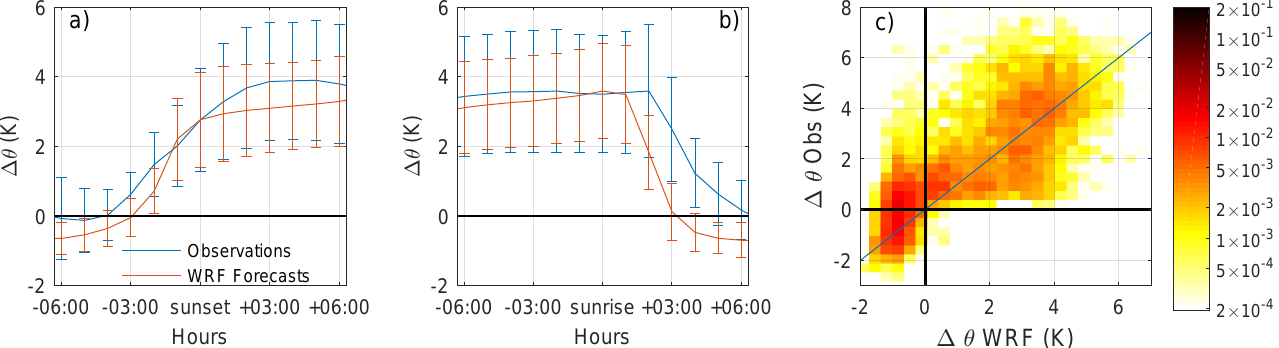
Figure 5. ( a ) Sunset-referenced mean diurnal cycle of potential temperature difference between 110m and 2m (1 year data). Blue color is for observations and red for simulations. Vertical bars represent standard deviations computed for each hour over the whole year. ( b ) Identical to subfigure ( a ) but sunrise-referenced. ( c ) Probability density function showing the correlation between observed and forecasted potential temperature